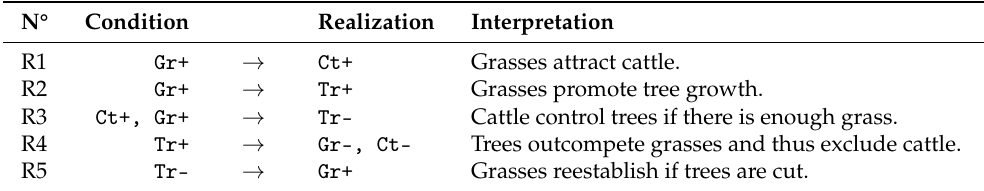
Table 1. Rule set of the “Grasses-Trees-Cattle” toy model. Variables are Gr (Grasses), Tr (Trees), and Ct (Cattle), which mostly consumes